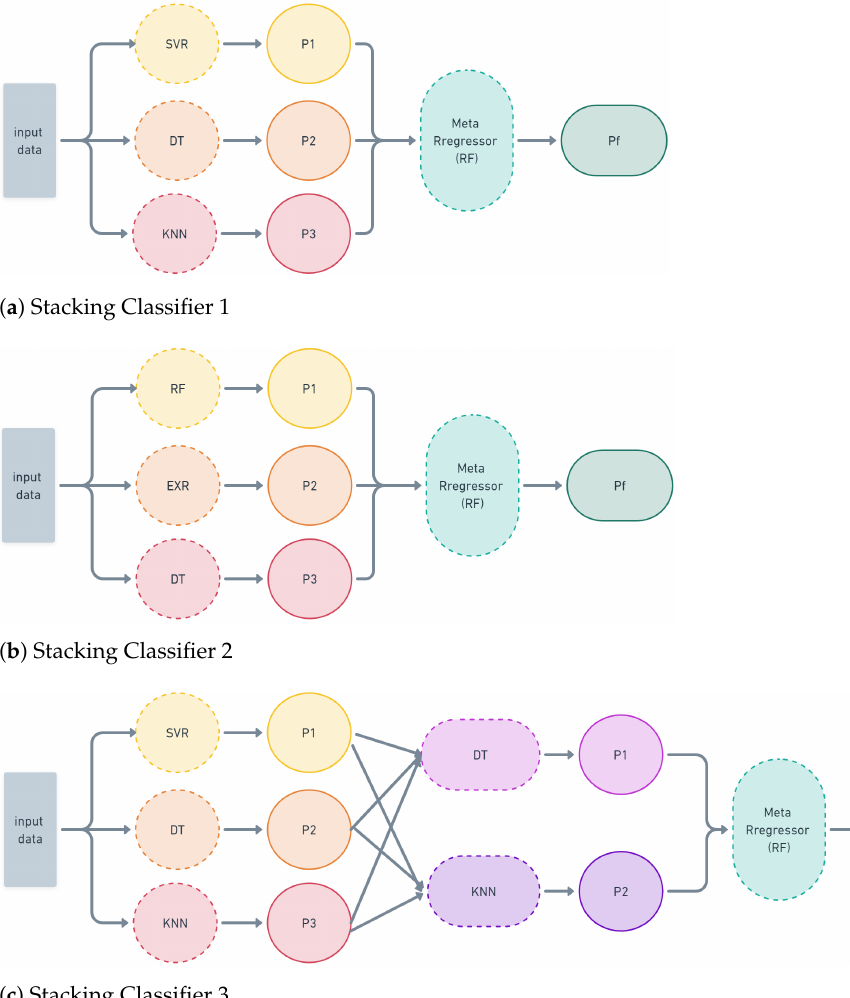
Figure 4. Structure used for the Stacked Classification